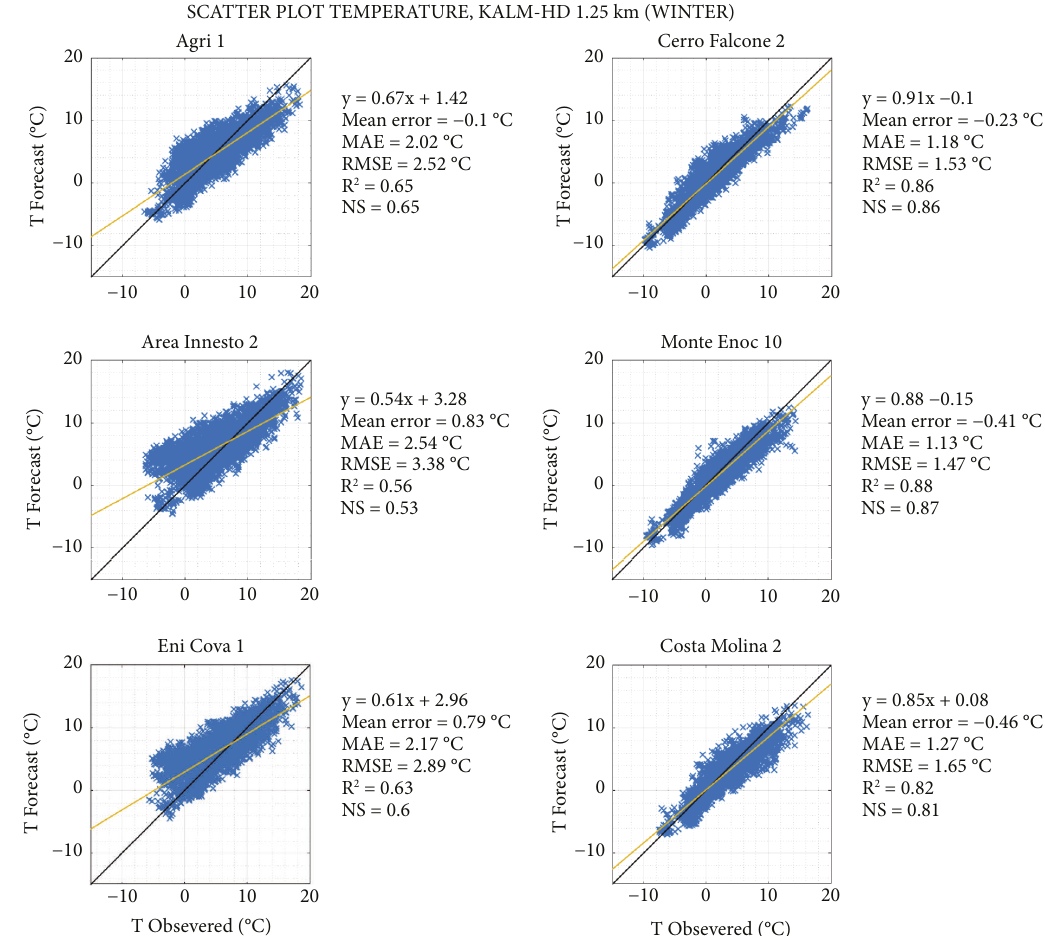
Figure 8: Scatter plots of the KALM-HD model with 1.25km as grid resolution vs. observed data for the hourly temperature forecast in winter (DJF), over the six stations at day +1 as lead time for the whole two years of the observation period. On the left are the “valley stations,” and on the right are the “mountain